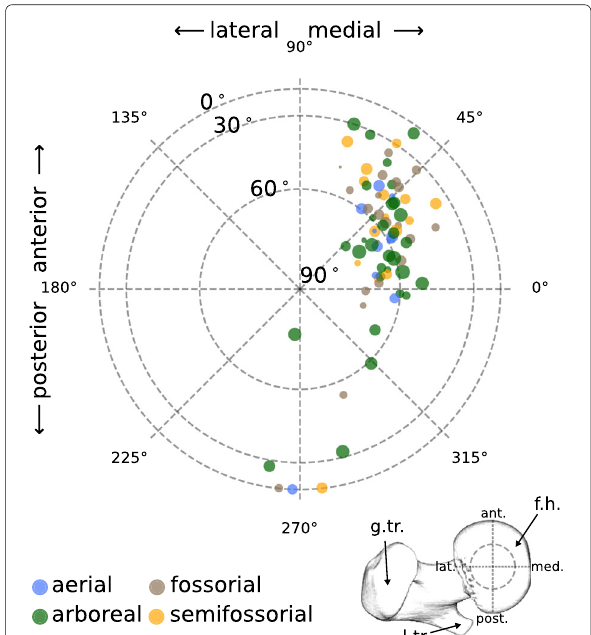
Fig. 3 Trabecular orientation. The main direction of trabecular anisotropy ( MDT ) is represented by vectors originating in the center of the femoral head and projected onto its proximal hemisphere. A femur, seen in proximal view, is depicted at lower right to illustrate the orientation (g.tr./l.tr., greater/lesser trochanter; f.h., femoral head). Data points close to the center are oriented more proximodistally. Colors indicate the lifestyle categories, circle size the degree of anisotropy ( DA ), ranging from 0.451 (smallest circle) to 0.883 (largest circle). The data show the results for left femora (right femora were mirrored)